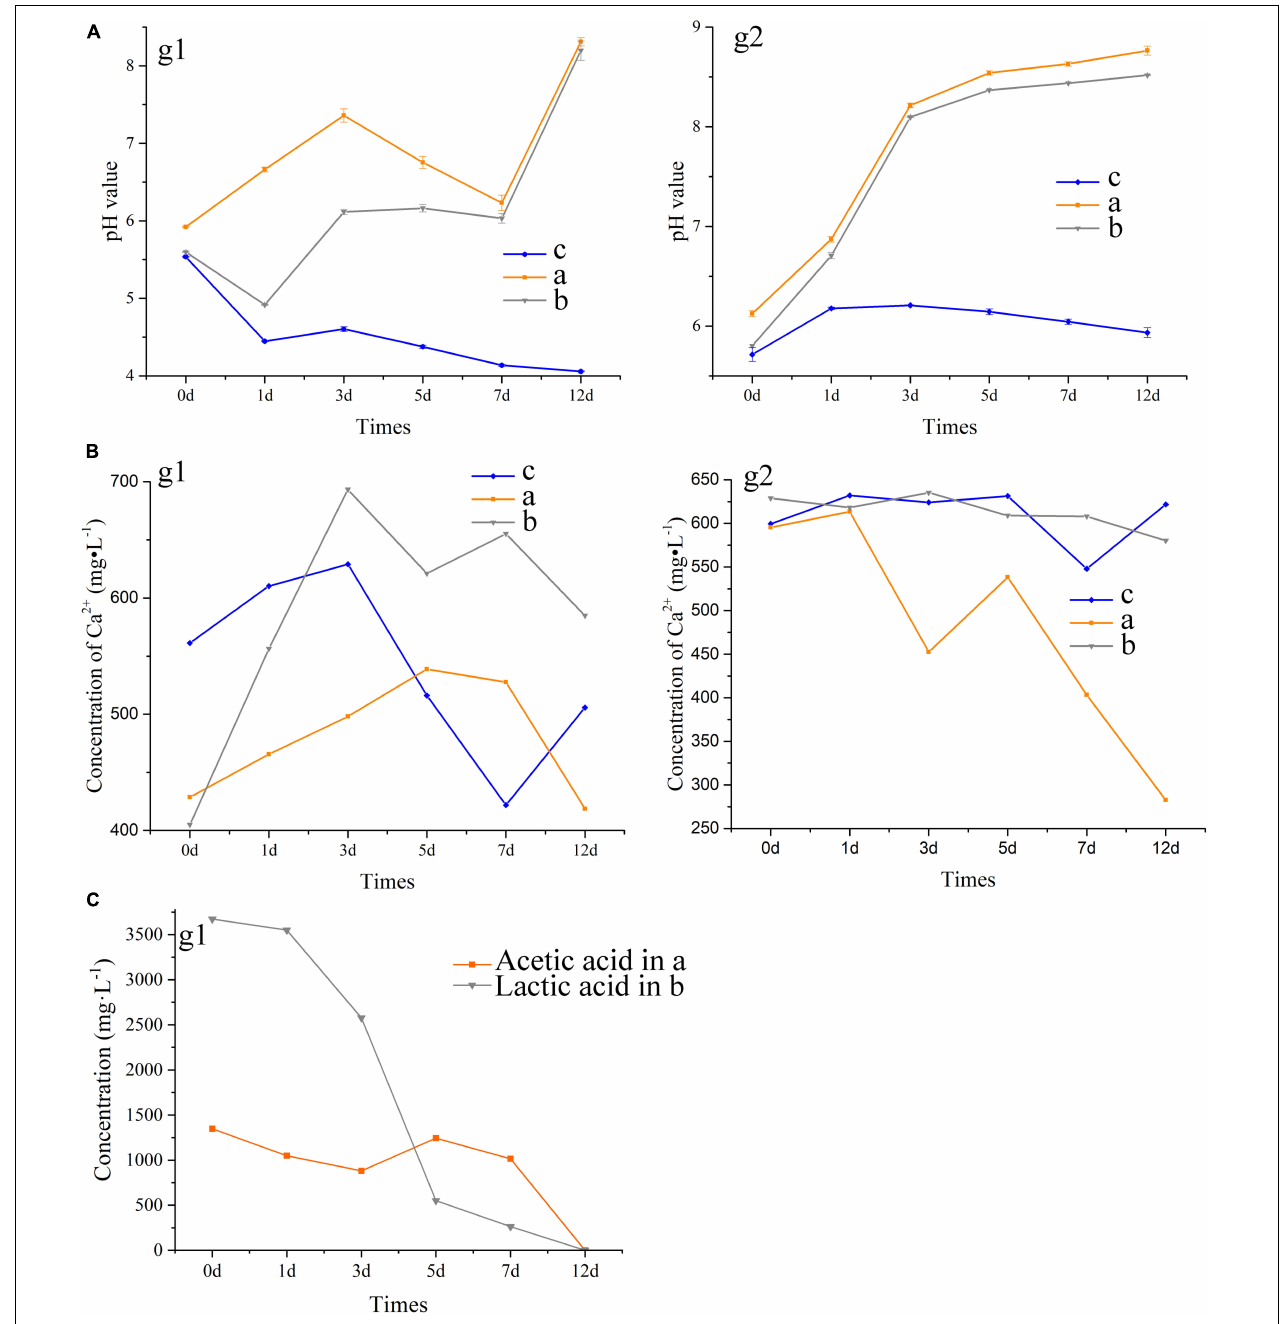
FIGURE 3 | Tendency of pH value (A) and the concentration of Ca 2 + (B) and organic acids (C) in the extracellular metabolites of S. cerevisiae . a, acetate in B4 medium; b, lactate in B4 medium; c, acetate in B4 medium without glucose. g1, the medium with glucose; g2, the medium without glucose.